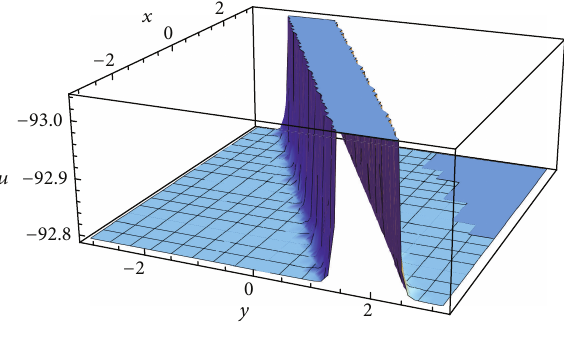
Figure 1: Profile of solution